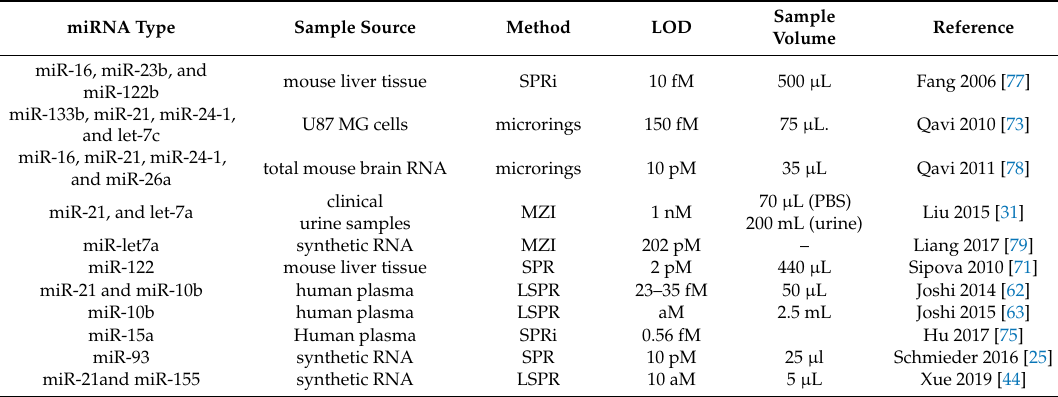
Table 1. Comparison of label-free microRNA optical sensors.